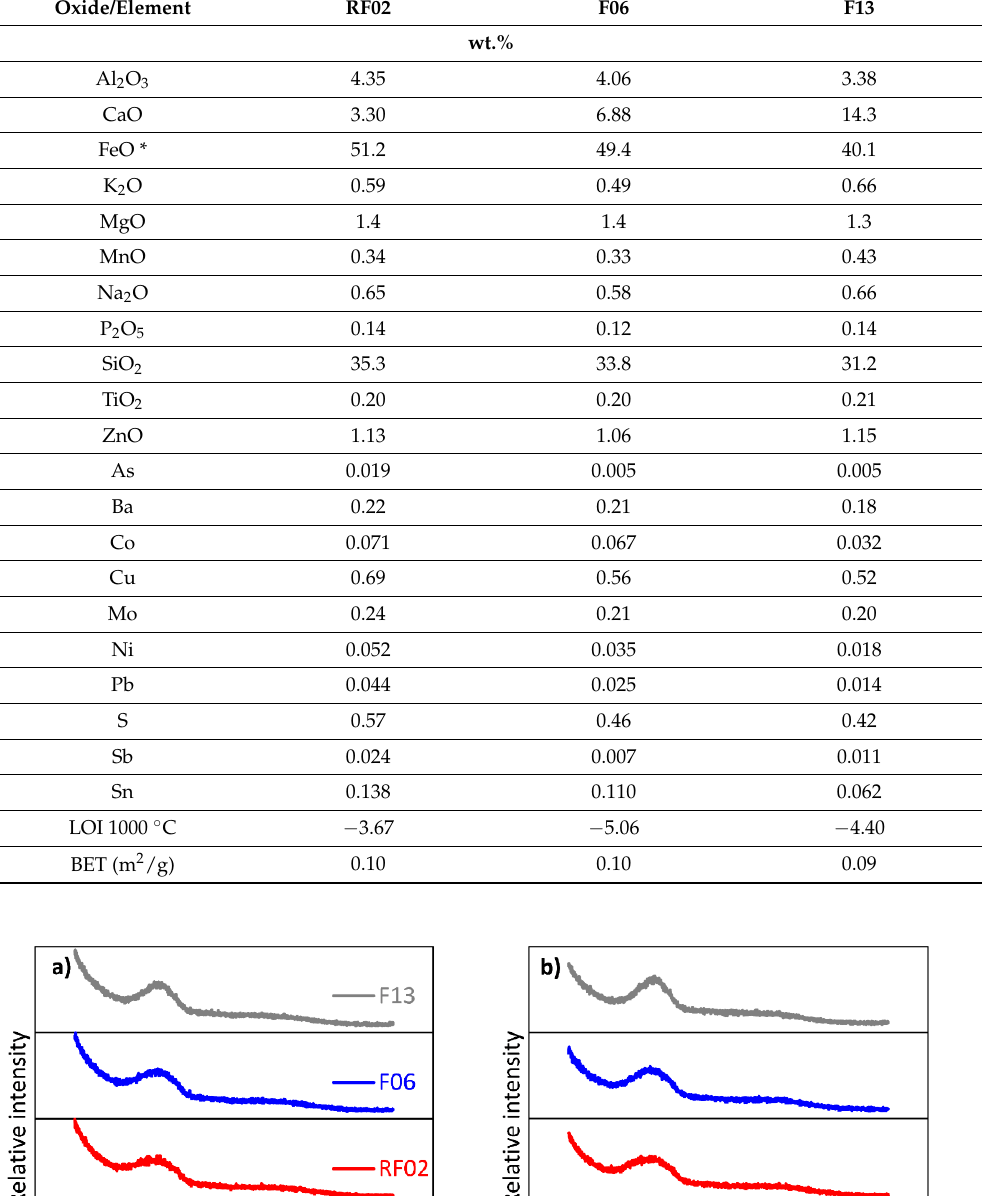
Table 1. Chemical compositions (wt.%) of main oxides and elements of 0.3–0.6 mm samples analyzed by ICP–MS and sample data. * Total Fe calculated as Fe 2+ .